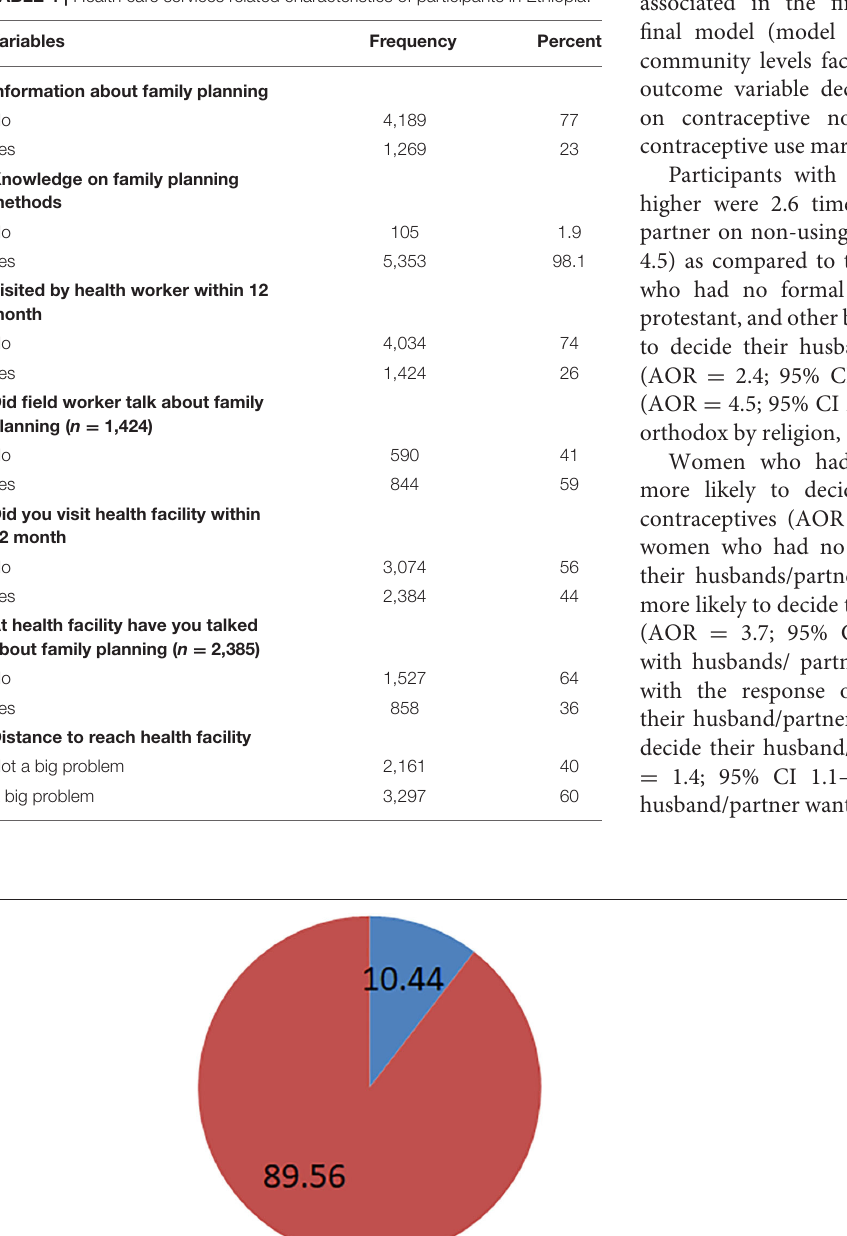
TABLE 4 | Health care services related characteristics of participants in Ethiopia.